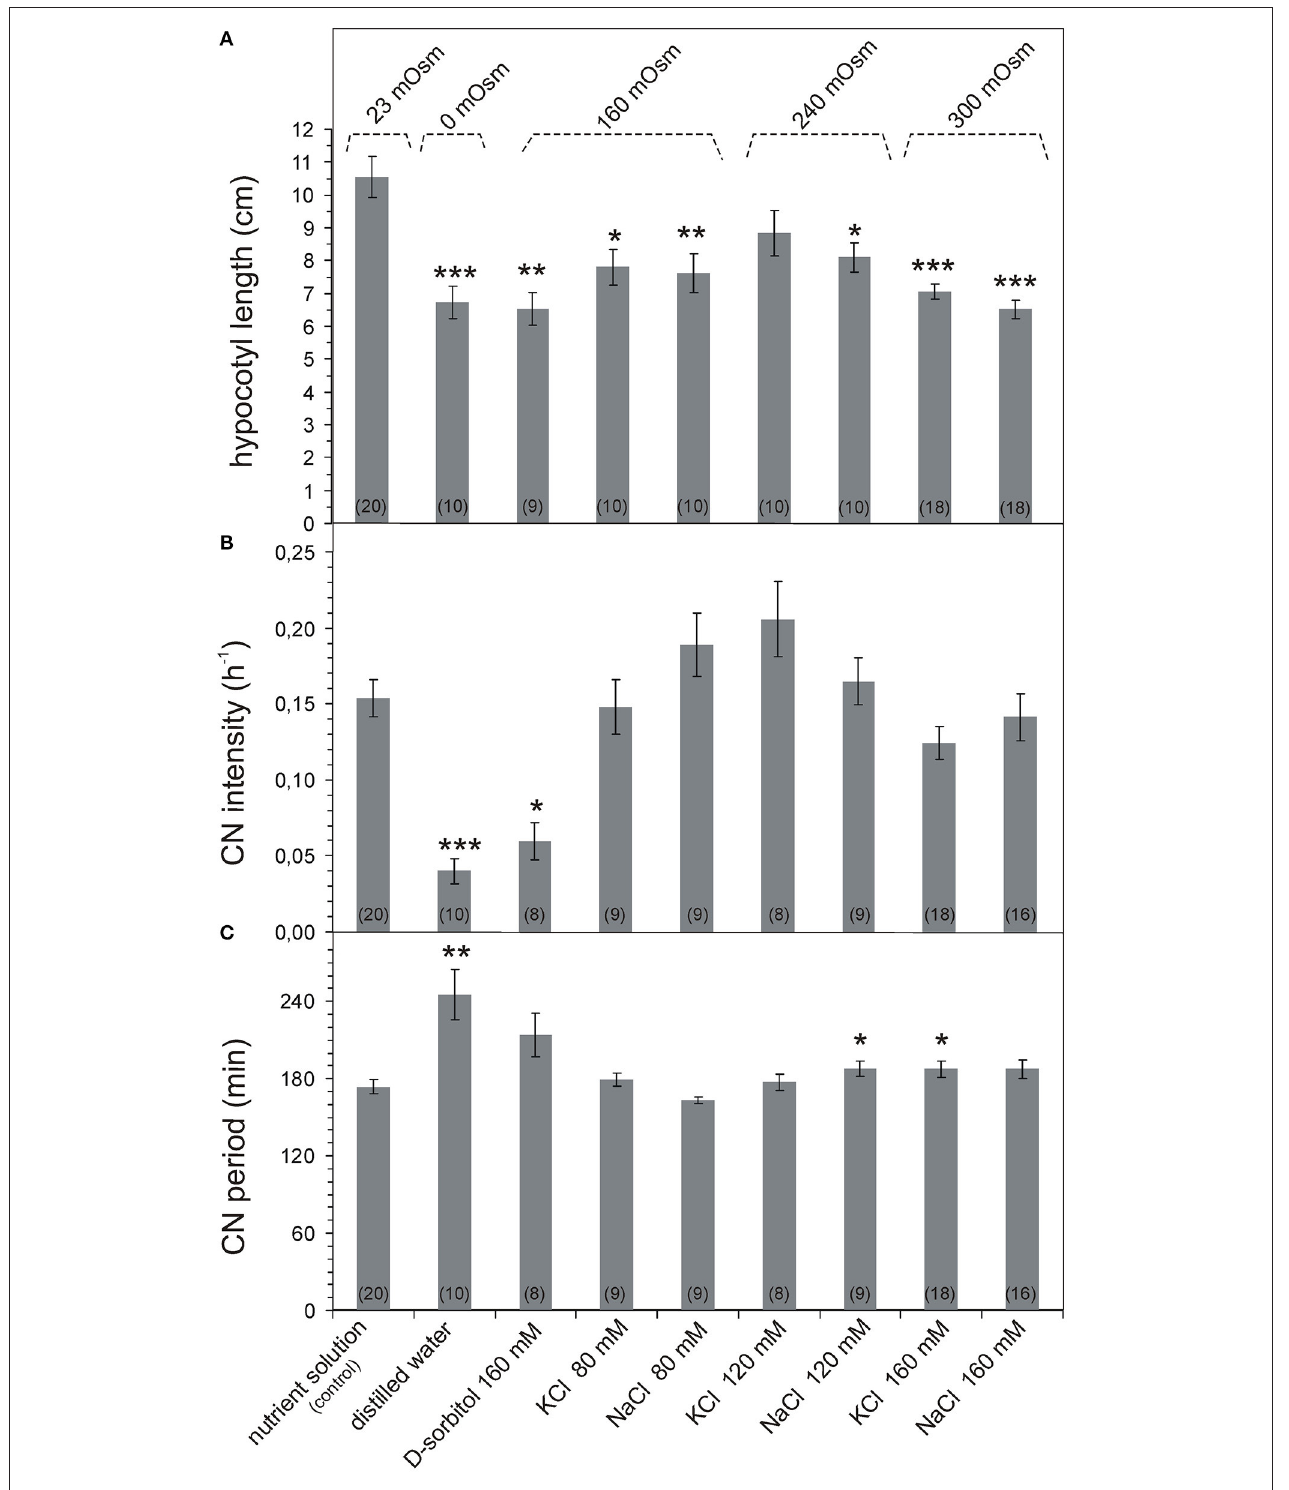
FIGURE 1 | Parameters of growth and CN of Helianthus annuus seedlings under osmotic and salt stresses. Bars represent mean ± SE. The number of plants is indicated in parentheses. The data were tested for normality distribution using the Shapiro-Wilk test. The the non-parametric Mann-Whitney U -test for pairwise analysis (A,C) and Tukey test (B) were used to assess the statistical difference between the control plants and each sunflower group growing in different nutrients; p -value ranges are marked by asterisks: *** p < 0.001,** p < 0.01,* p < 0.05. (A) Changes in hypocotyl length, data normally distributed, unequal variance